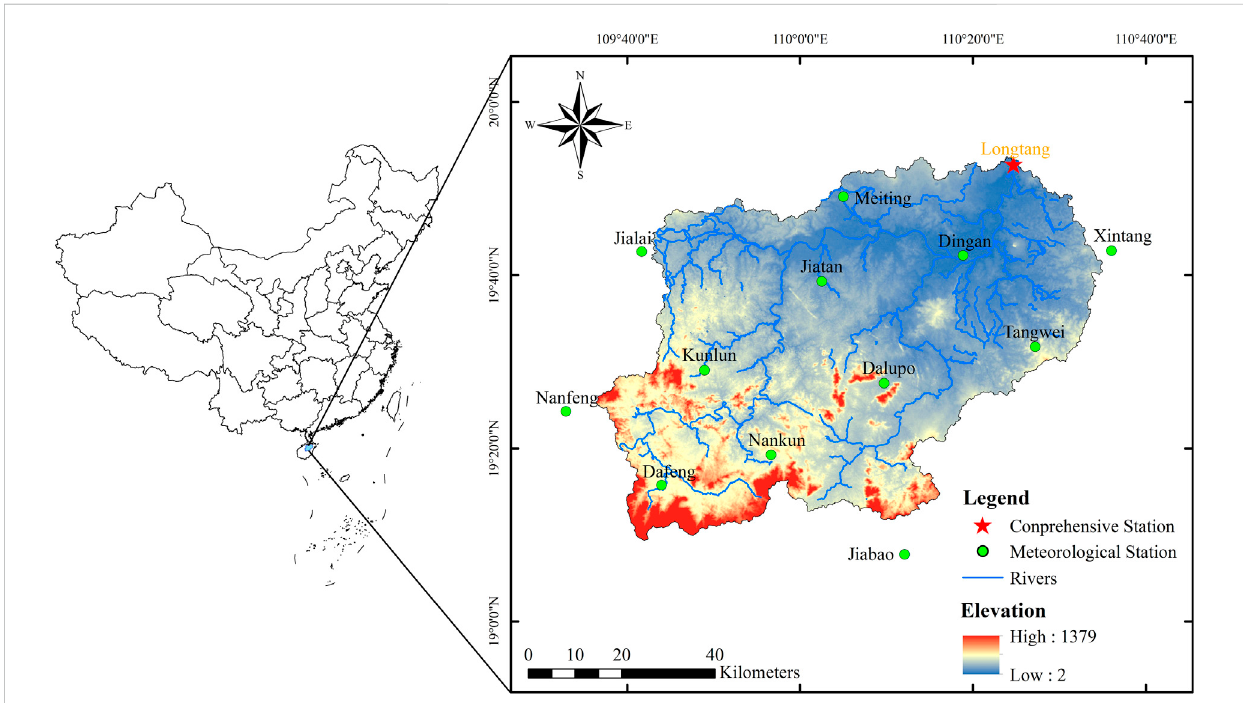
FIGURE 1 Location map of the study area. The comprehensive station has meteorological observation data and hydrological observation